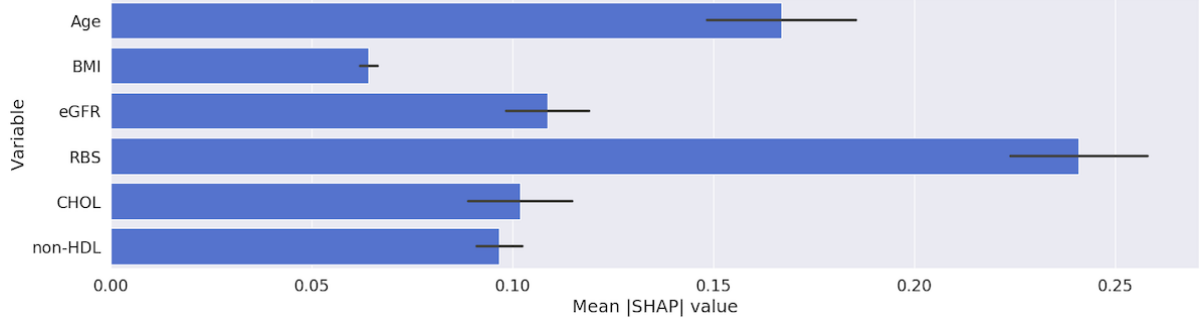
Figure 6. Relative importance of predictors obtained from the multilayer perceptron trained with longitudinal data using SHAP. CHOL: total cholesterol; eGFR: estimated glomerular filtration rate; non-HDL: non–high-density lipoprotein; RBS: random blood sugar; SHAP: Shapley Additive